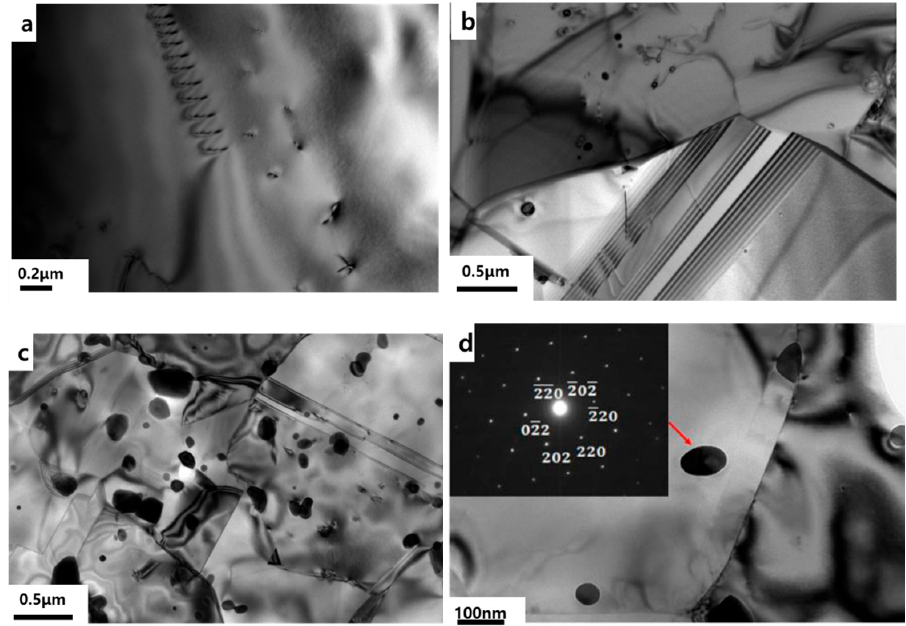
Figure 5. Transmission electron microscope (TEM) images of solution-treated (NiCo) 75 Cr 17 Fe 8 C 0.83 ( a ), annealed (NiCo) 75 Cr 17 Fe 8 C 0.34 ( b ) and annealed (NiCo) 75 Cr 17 Fe 8 C 0.83 ( c , d ).